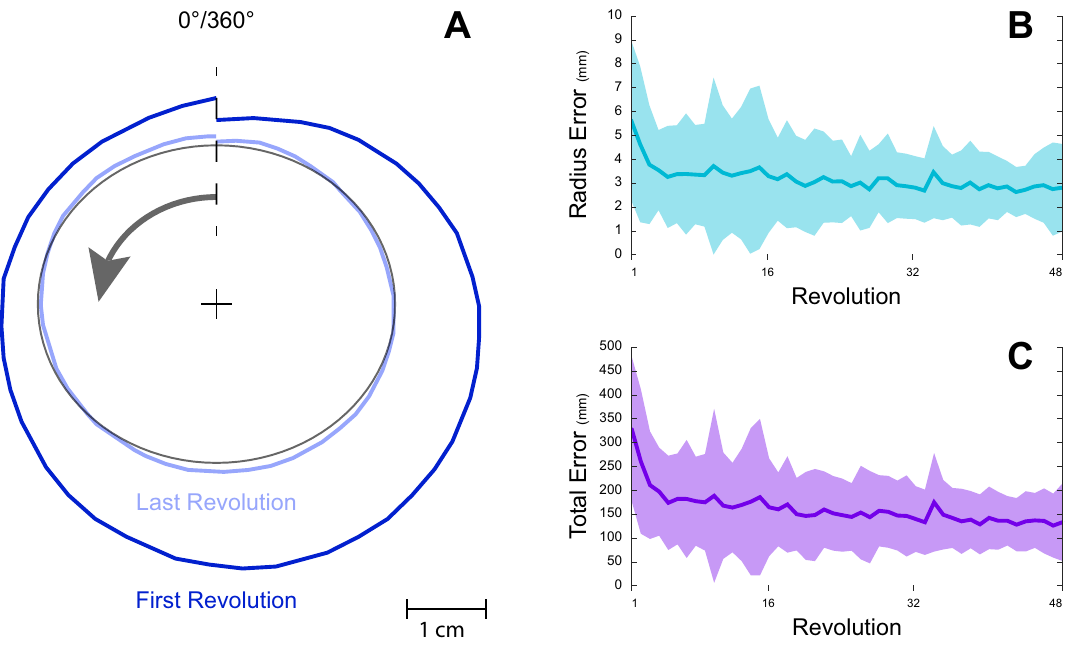
Figure 4. Example traces and error reduction. ( A ) Example of traces performed by a subject. The black circle represents the template on which tracings were performed in a counterclockwise manner (arrow). In dark blue is the tracing of the first revolution, whereas in light blue is the tracing of the last revolution. ( B , C ) Results for radius error ( B ) and for total error ( C ) per revolution for all subjects, it is possible to see that both radius and total errors gradually reduce during the task. Specifically, initial radius error reduced from 5.65 ± 3.35 mm for the first revolution to 2.81 ± 1.83 mm by the last revolution, and total error reduced from 329.2 ± 151.7 mm to 133.47 ± 81